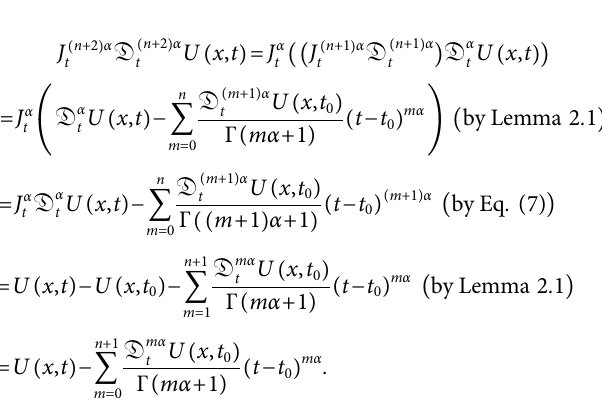
( x , t ) and U ( x , t ) in Eq. 81 and the ES of U 1 2